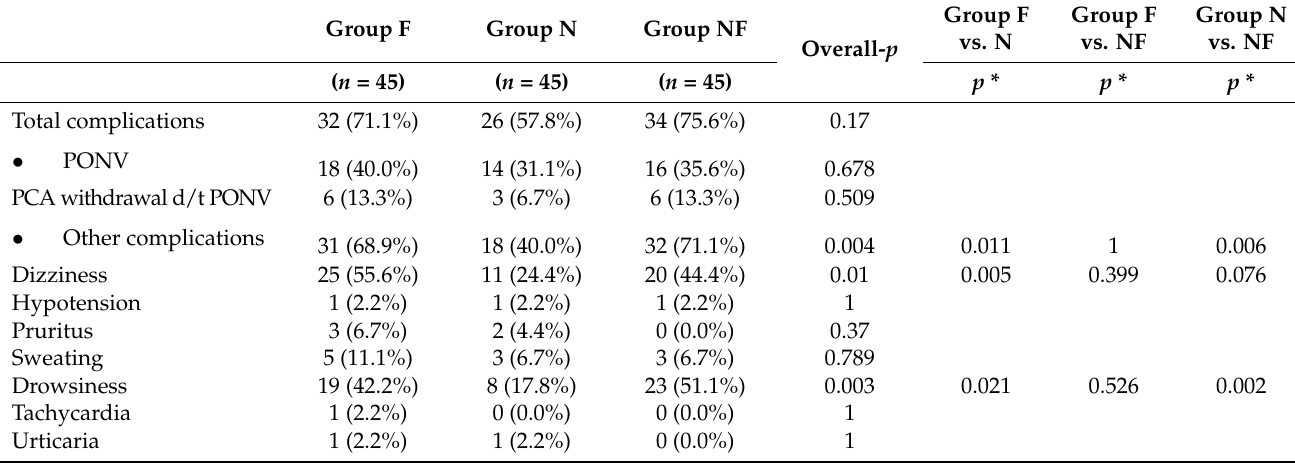
Table 3. Postoperative complication and patient-controlled analgesia withdrawal due to postoperative nausea and